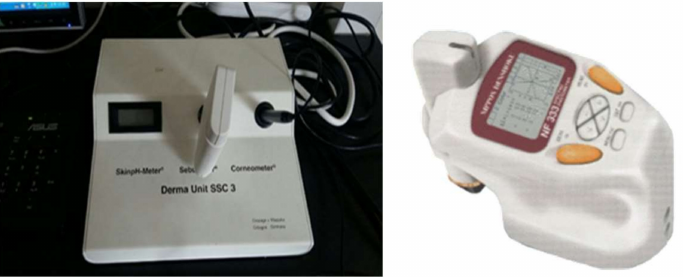
Figure 1. Three-in-one skin analyzer and NF333 spectrophotometer.